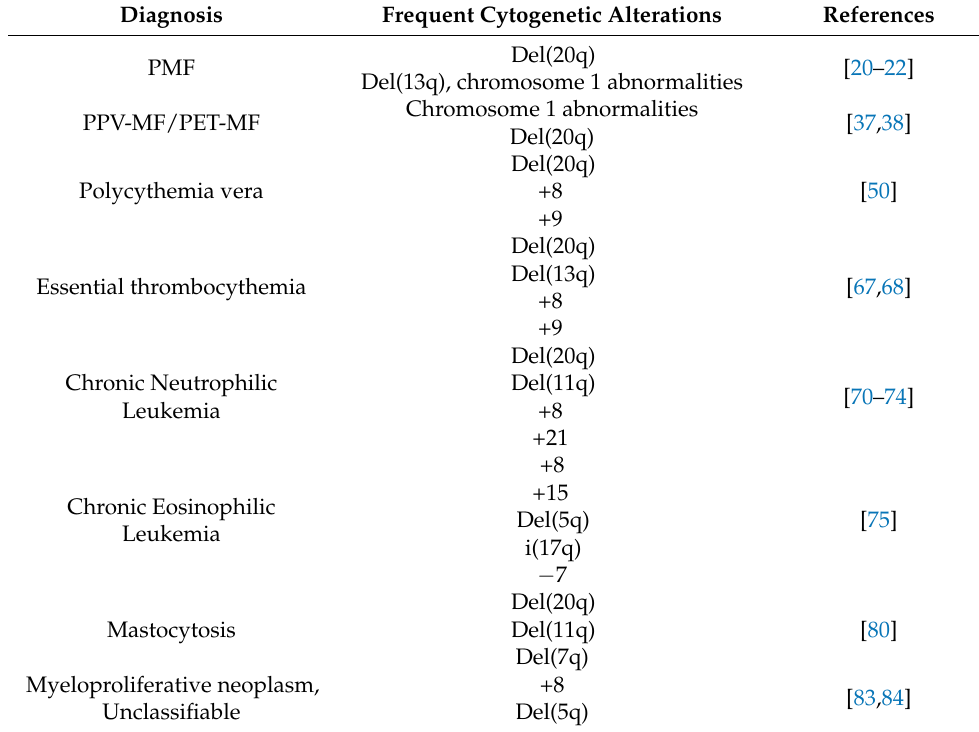
Table 2. Common cytogenetics alterations in